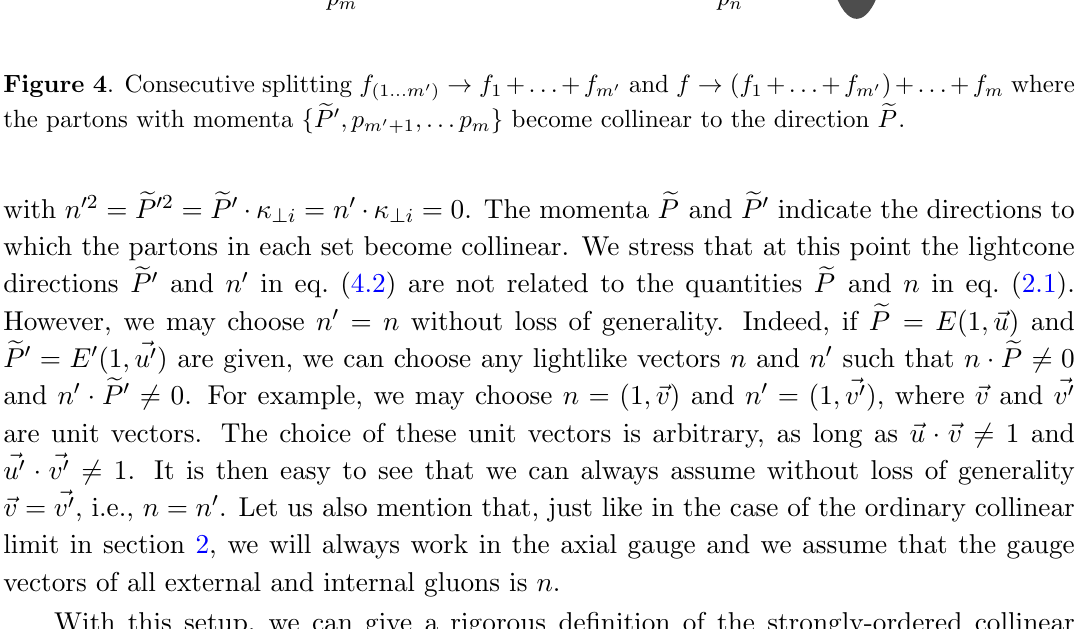
→ f 1 + . . . + f m ′ and f → ( f 1 + . . . + f m ′ )+ . . . + f m where (1 ...m ′ )